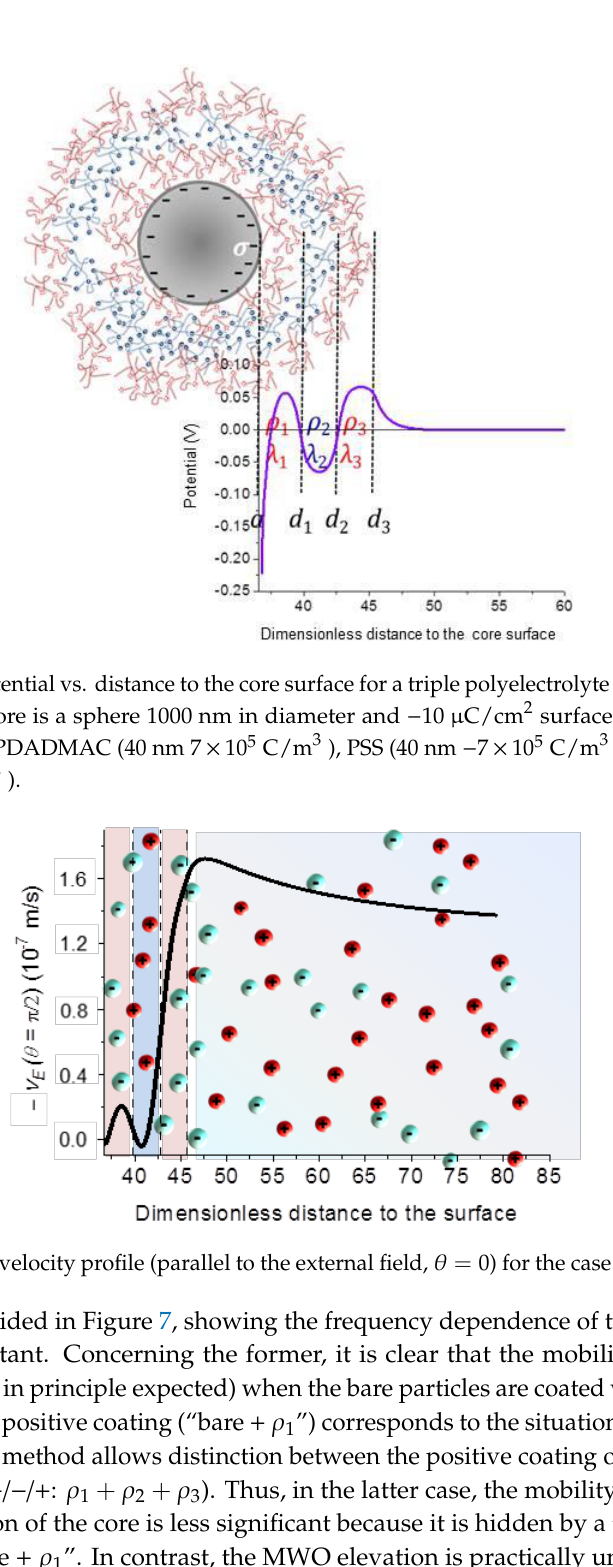
Figure 6. Tangential velocity profile (parallel to the external field, 0  ) for the case shown in Figure 5.